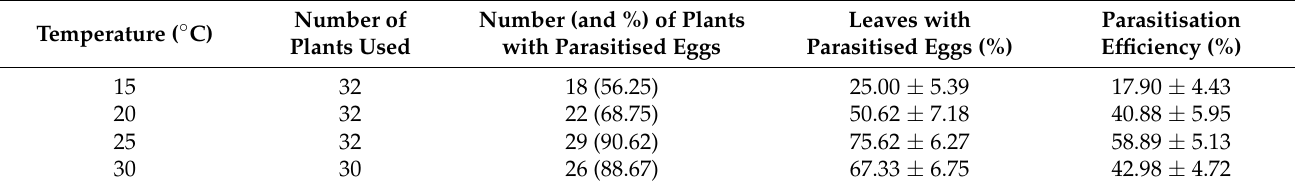
Table 1. Trichogramma achaeae parasitising Ephestia kuehniella eggs: number (percentage) of plants with parasitised eggs, mean ( ± standard error of the mean (SEM)) percentage of leaves with parasitised eggs per plant and parasitisation efficiency (percentage of parasitised eggs) at four constant